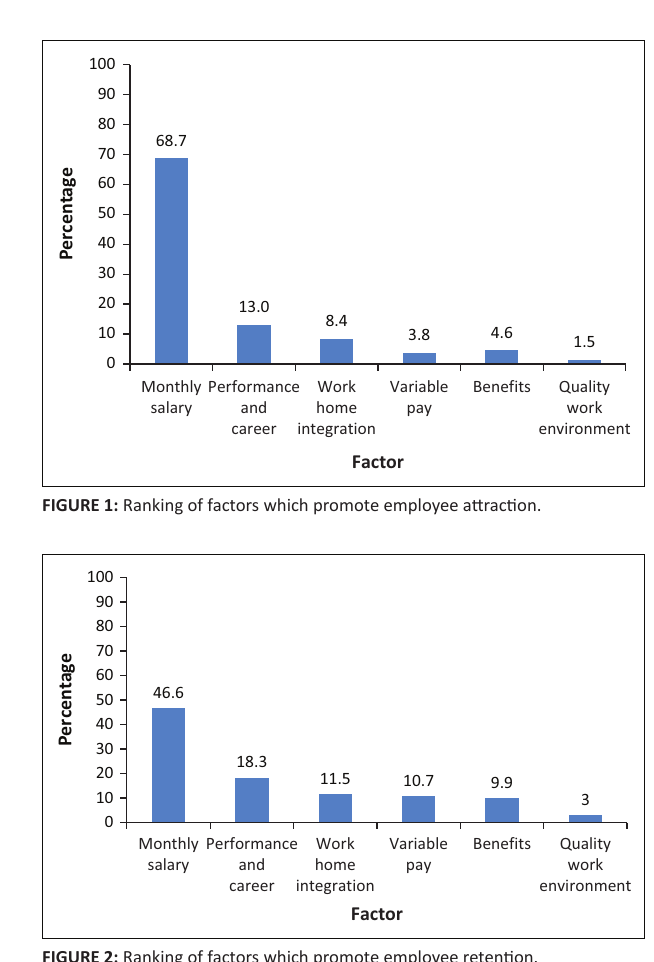
FIGURE 2: Ranking of factors which promote employee retention.